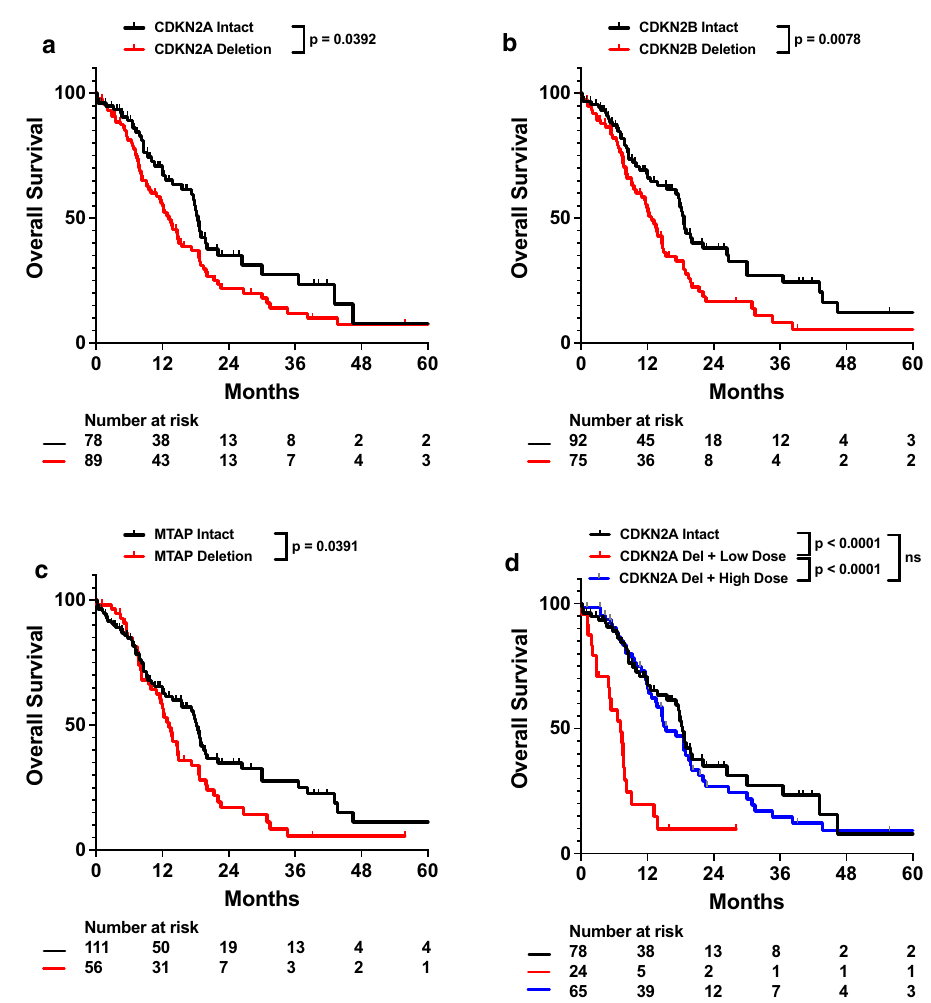
Fig. 2 Univariate impact of CDKN2A homozygous dele- tion, CDKN2B homozygous deletion, MTAP homozygous deletion, on OS in full patient cohort. Kaplan–Meyer plots of OS comparing patients with different ( a ) CDKN2A, ( b ) CDKN2B, or ( c ) MTAP are shown. ( d ) Plot of OS comparing patients receiv- ing at least 45 Gy radiation (labeled as High Dose) or less than 45 Gy radiation (labeled as Low Dose) with different CDKN2A deletion status is also shown. Statistical analysis was performed using Cox Proportional Hazards tests. OS, overall